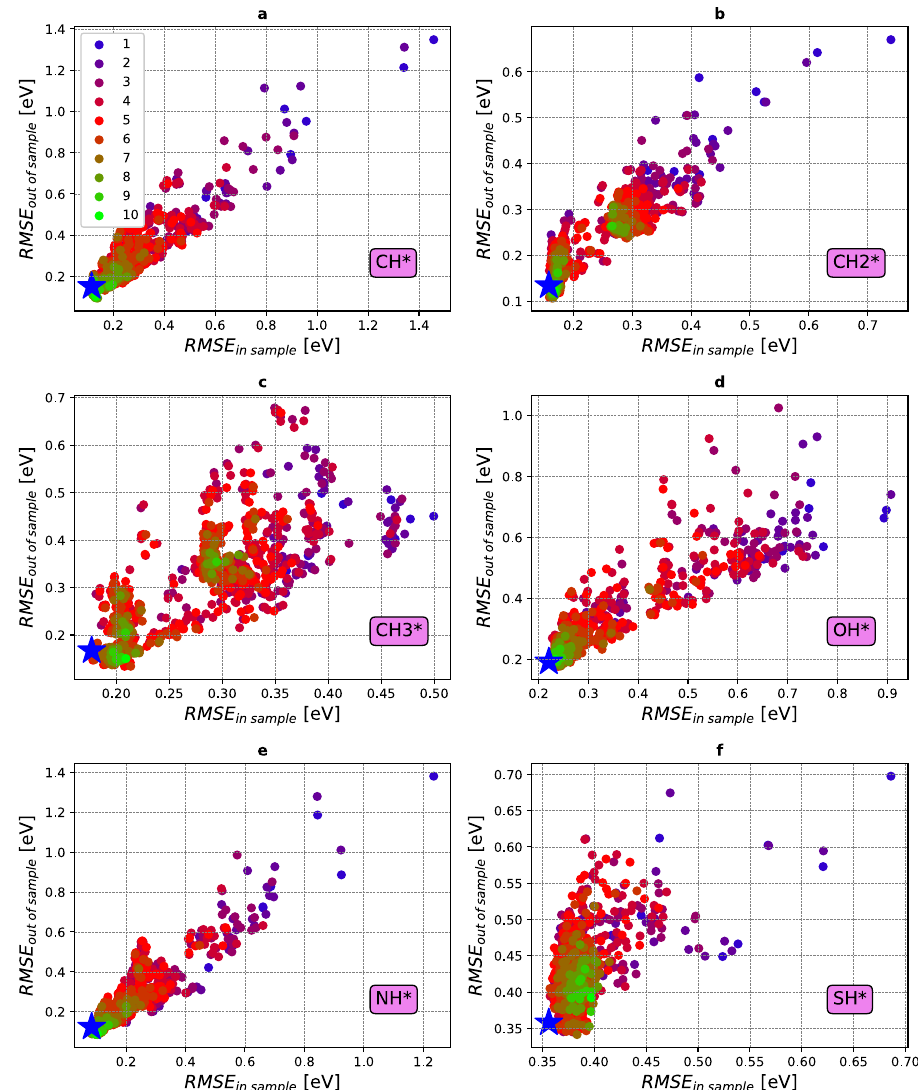
Fig. 3 Comparison of RMSE values for in sample and out of sample prediction for all models. The blue star indicates the best model (with the lowest BIC value). a CH *, b CH 2 *, c CH 3 *, d OH *, e NH *, and f SH *. The points are color coded to show the number of parameters used in that